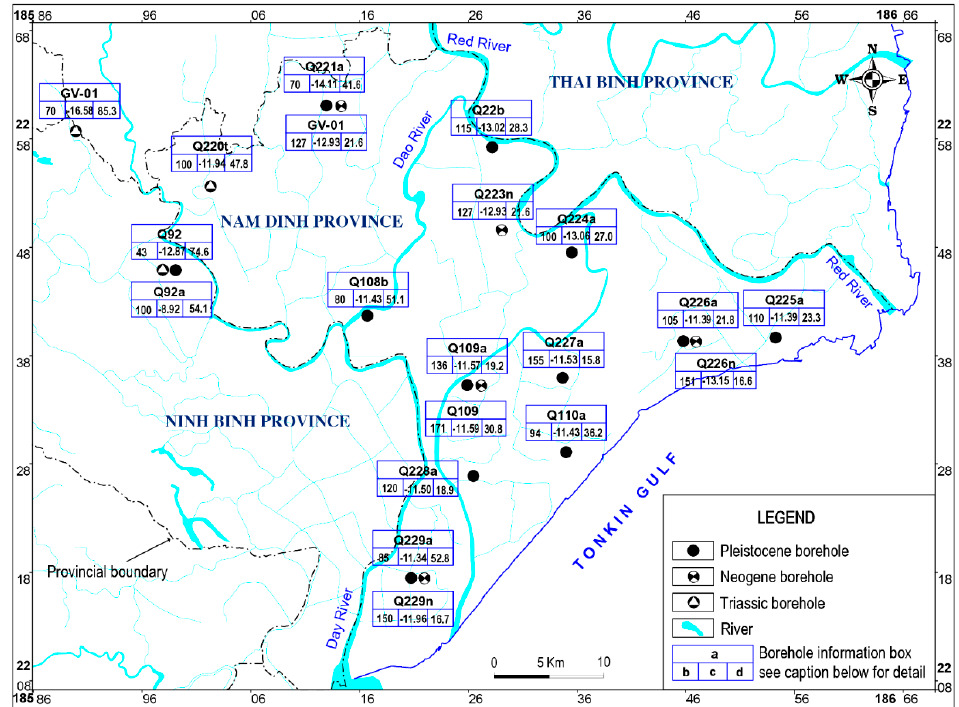
Figure 3. Sampling locations of the groundwater from Pleistocene, Neogene and Triassic aquifers along with information related to boreholes and water in the boreholes. In the borehole information box: a: Borehole ID (Q stands for boreholes of the National Groundwater Monitoring Network with a sequence number in the Network; Characters a or b, n and t standing aside the borehole ID indicate the Pleistocene, Neogene and Triassic aquifers, respectively); b: borehole depth (meter from the ground surface); c: δ 13 C of DIC (‰); d: 14 C content in DIC (pMC).